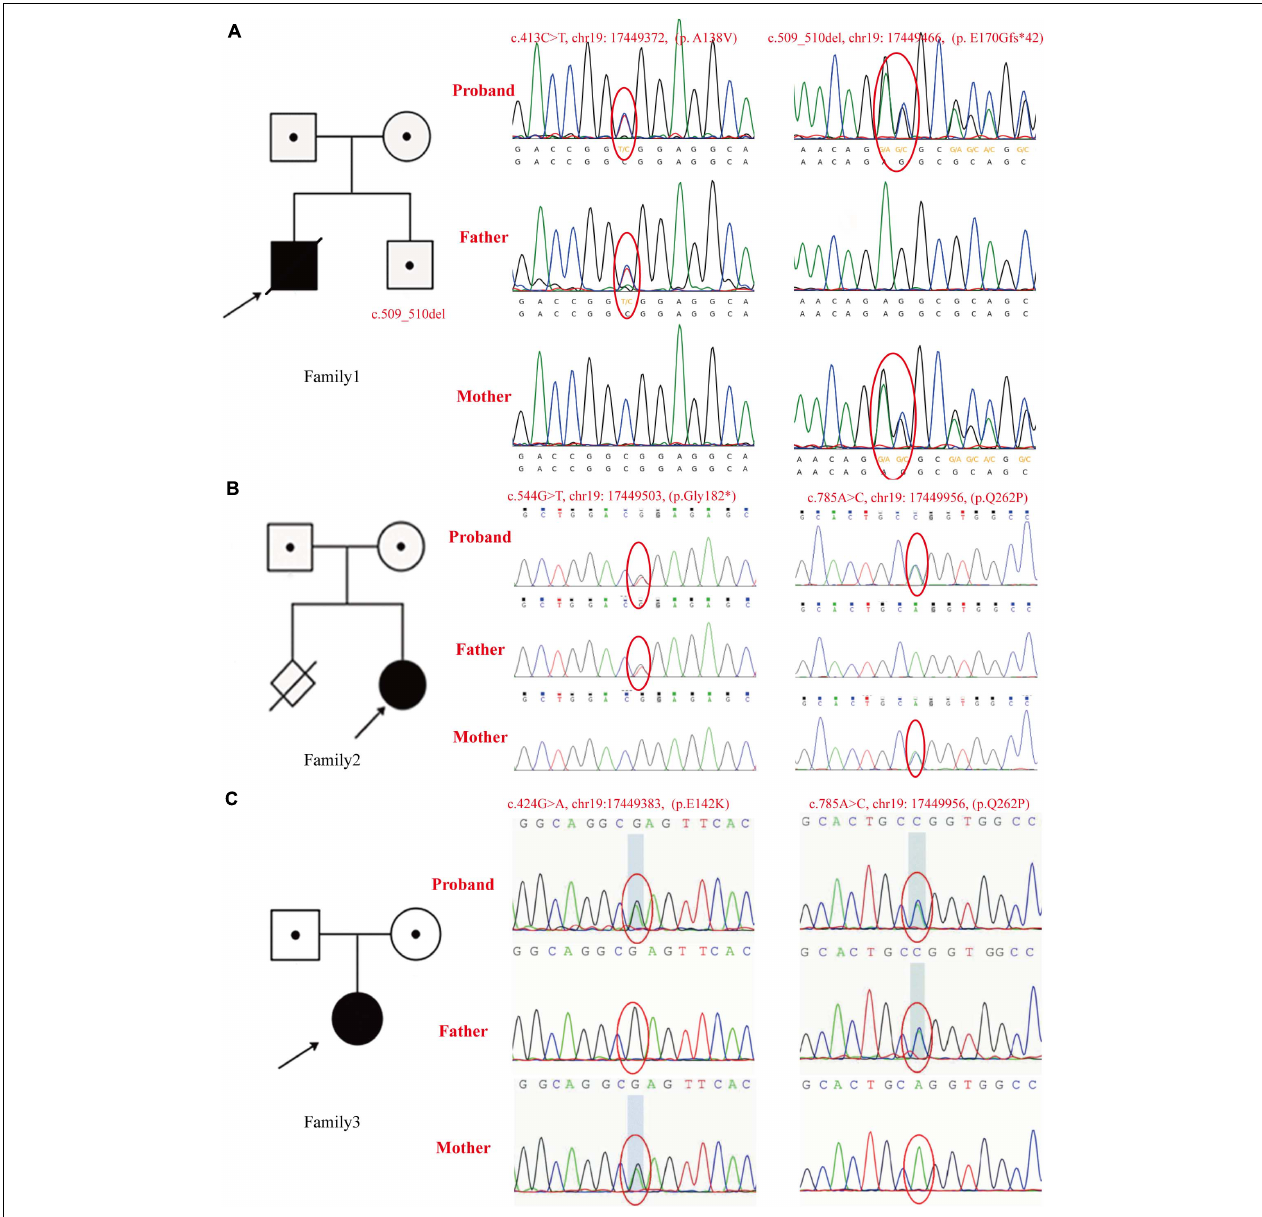
FIGURE 3 | The pedigrees and identified GTPBP3 mutations. (A) In family 1, the c.413C > T (p. A138V) mutation was detected in the proband and his father, c.509_510del (p. E170Gfs*42) was detected in the proband and his mother. As shown in the pedigree of the nuclear family, c.509_510del (p. E170Gfs*42) was found in his brother as validated by Sanger sequencing. (B) Mutations identified in family 2 as confirmed by Sanger sequencing. The c.544G > T (p. G182X) mutation was found in the proband and her father, and the c.785A > C (p.Q262P) mutation was found in the proband and her mother. As shown in the pedigree of the nuclear family, there is a history of firstborn spontaneous abortion of the mother at the 7th week of gestation. (C) Mutations found in family 3 as confirmed by Sanger sequencing. The c.785A > C (p.Q262P) was found in the proband and her father, mutation c.424G > A (p.E142K) was found in the proband and her mother. The arrow indicates the